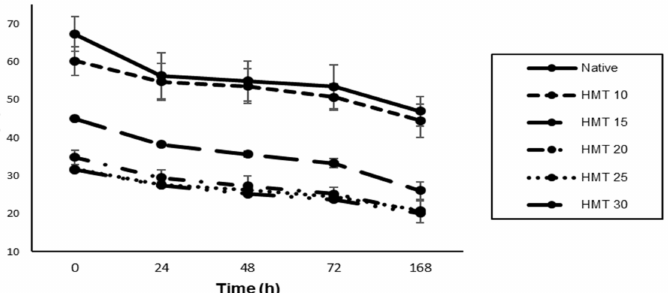
Figure 3. Paste clarity of native and HMT sago starch samples. Native indicates native starch, HMT indicates heat-moisture treatment starches. HMT 10, HMT 15, HMT 20, HMT 25, HMT 30 indicate the starch samples treated with HMT for the 10%, 15%, 20%, 25%, and 30% moisture treatments,